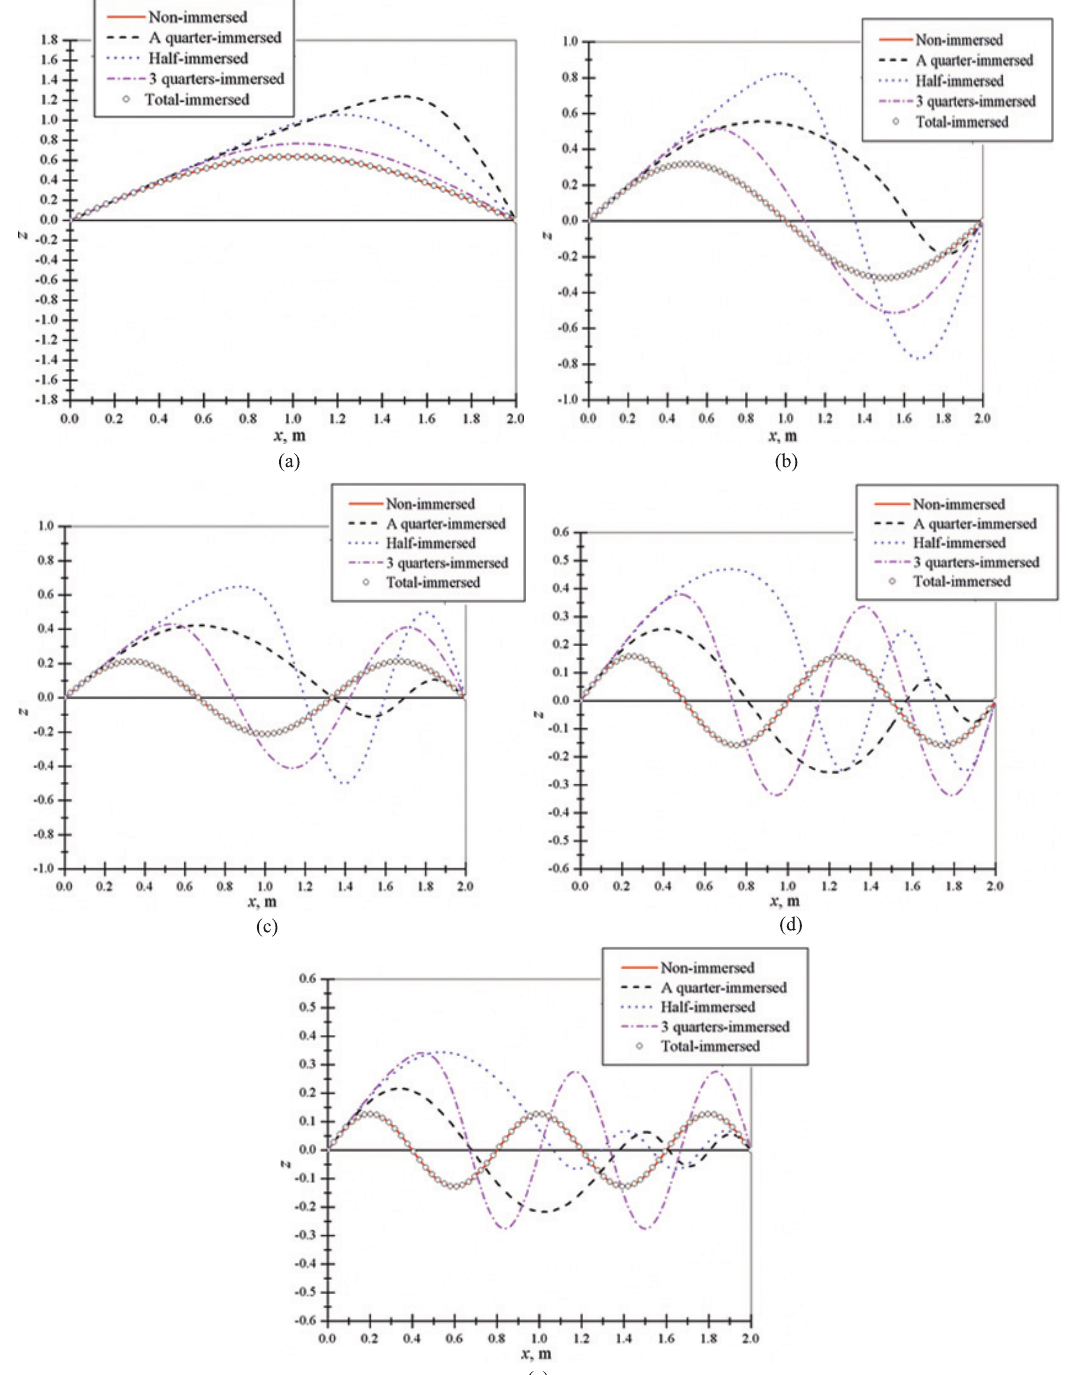
Fig. 8. Differences of the first five vibration modes for plates with various submerged depths by using the presented analytical method. (a) The first vibration mode; (b) the second vibration mode; (c) the third vibration mode; (d) the fourth vibration mode; (e) the fifth vibration